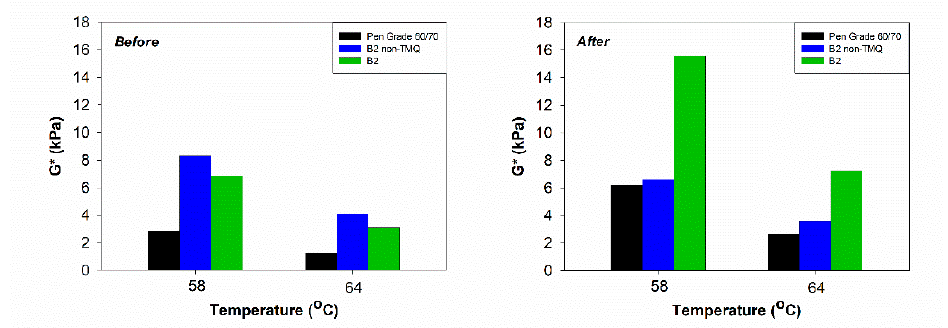
Figure 11. Complex Modulus Before and After Aging